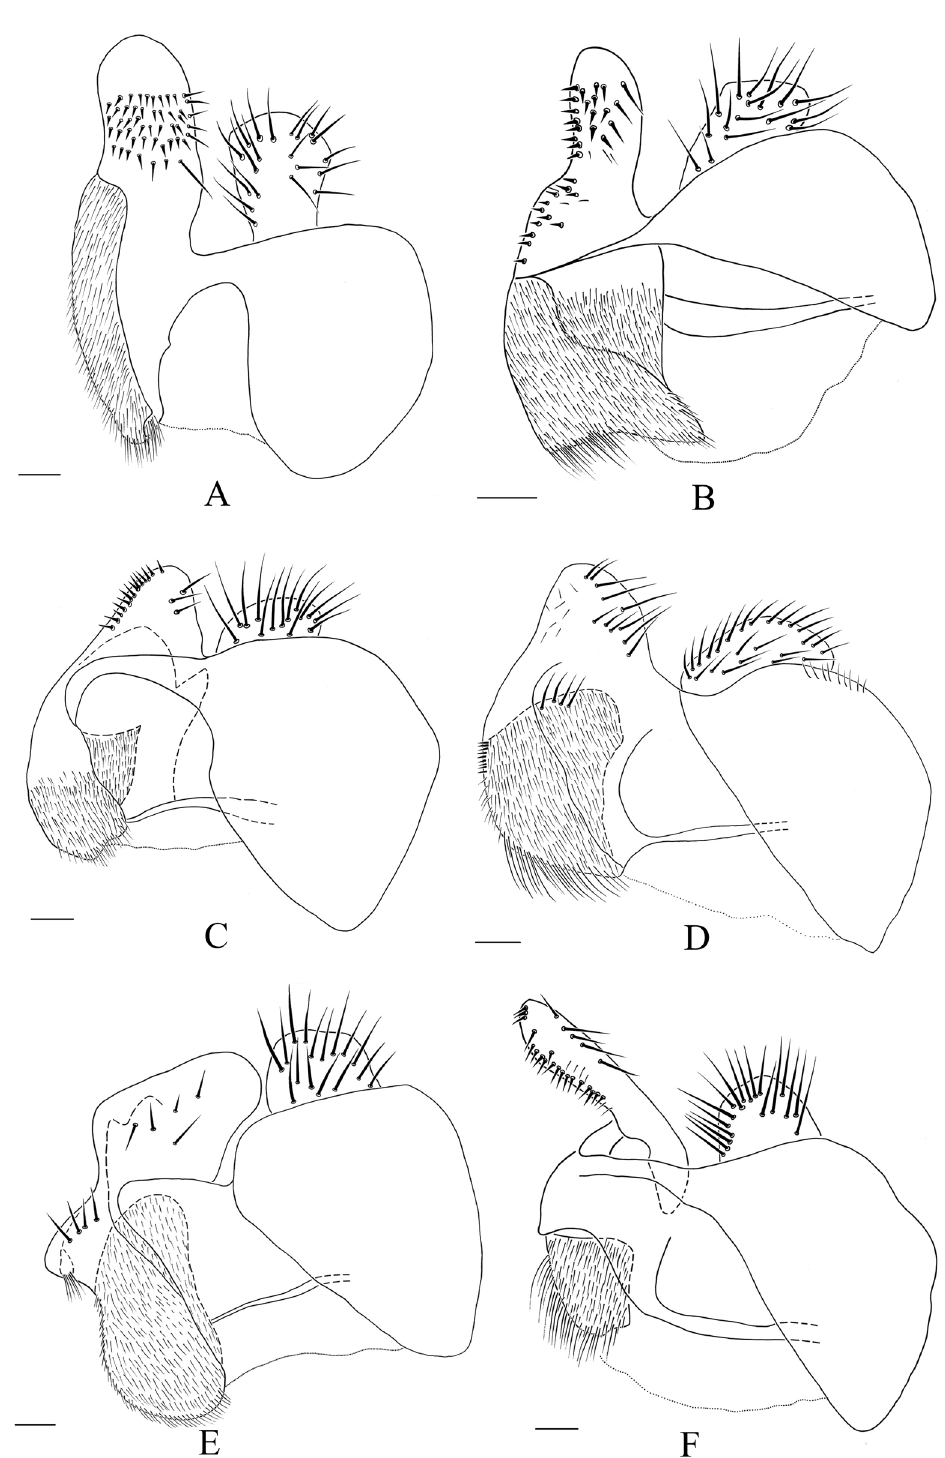
Fig. 18. Epandrium, cercus and surstylus, lateral view. A . Eumerus atricolorus Gilasian & van Steenis sp. nov., holotype (HMIM). B . E. brevipilosus Gilasian & van Steenis sp. nov., holotype (HMIM). C . E. chekabicus Gilasian & van Steenis sp. nov., holotype (HMIM). D . E. coeruleus (Becker, 1913), Chekab Valley, Iran (HMIM). E . E. ovoformus Gilasian & van Steenis sp. nov., holotype (HMIM). F . E. richteri Stackelberg, 1960, Lar, Iran (HMIM). Scale bars = 0.1